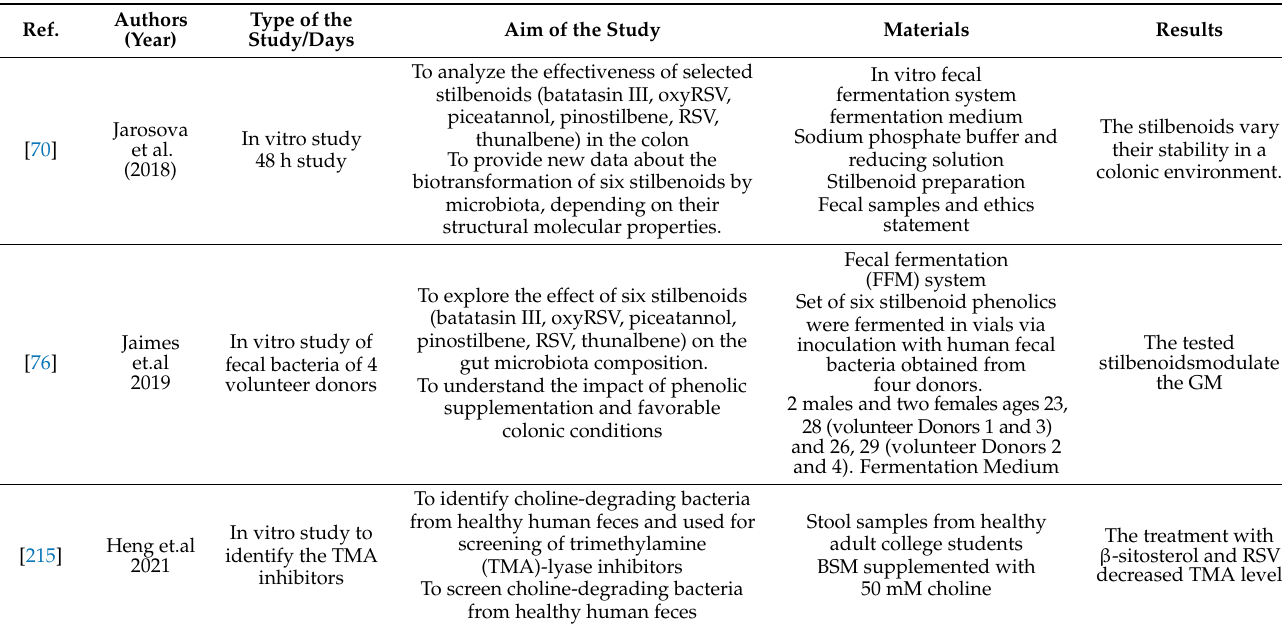
Table 4. Reported RSV results in the colonic environment and